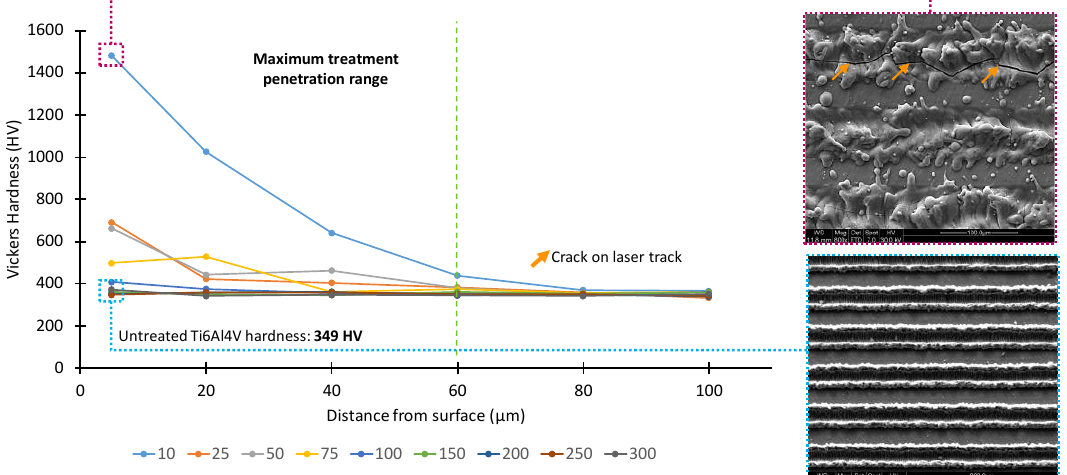
Figure 6. Hardness variation based on Vs and detail of laser track morphologies for 10 and 250 mm/s V s .